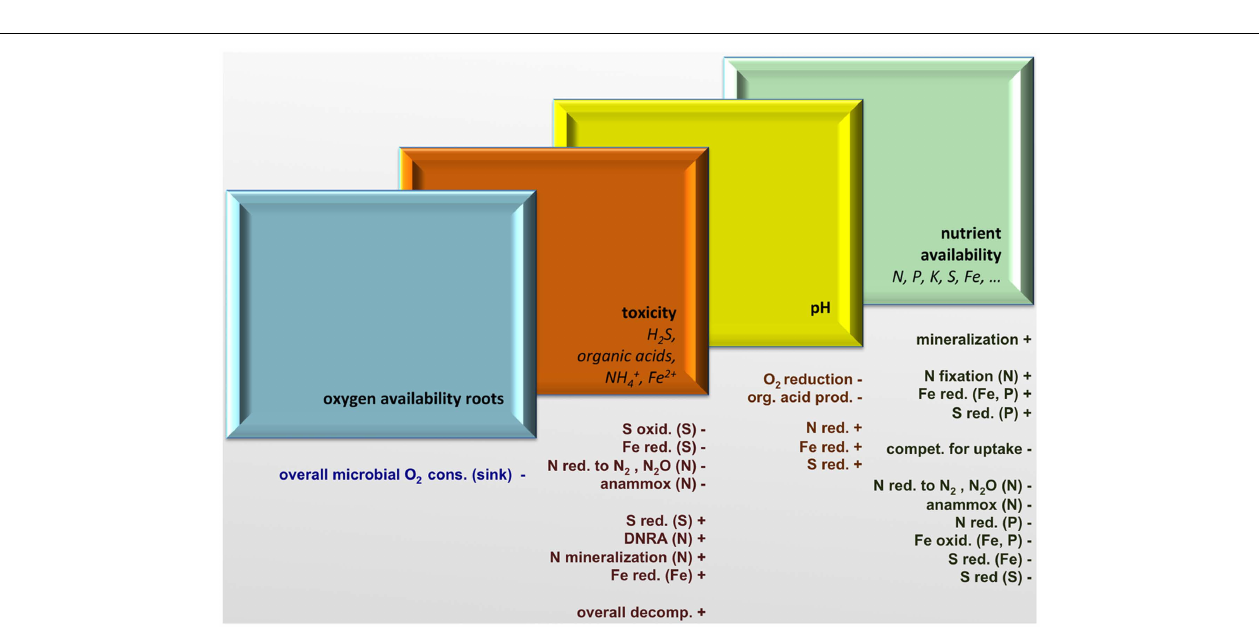
ammonium; SR, sulfate reduction; FeR, iron reduction, NOX, N oxidation to NO x , SOX, S oxidation; FeOX, Fe oxidation; DN, denitrification; Nfix, N 2 fixation; Anammox, anaerobic ammonium oxidation; ROL, radial oxygen loss (by roots).